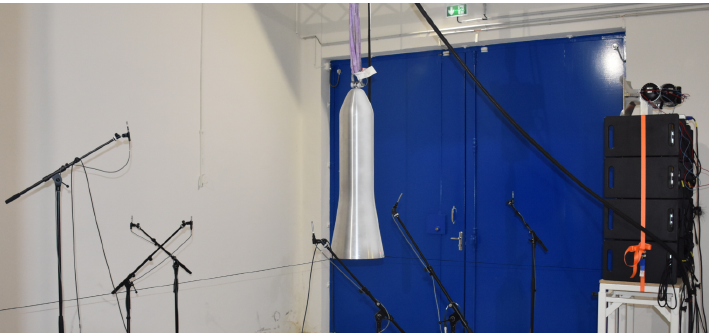
Figure 3. HB–2 structure in the vertical configuration in the reverberation chamber with the six control microphones and the loudspeakers on the right.